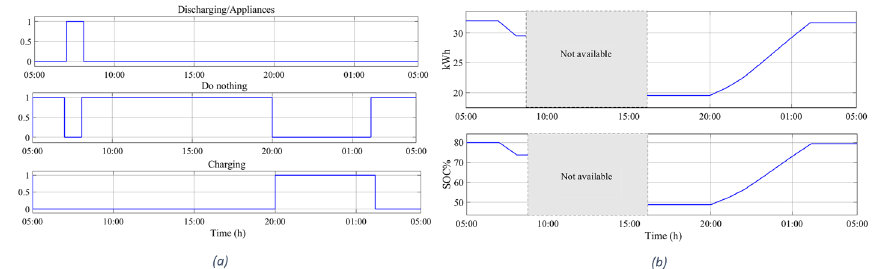
Fig. 12 a PEV management fuzzy controller output, b PEV power and